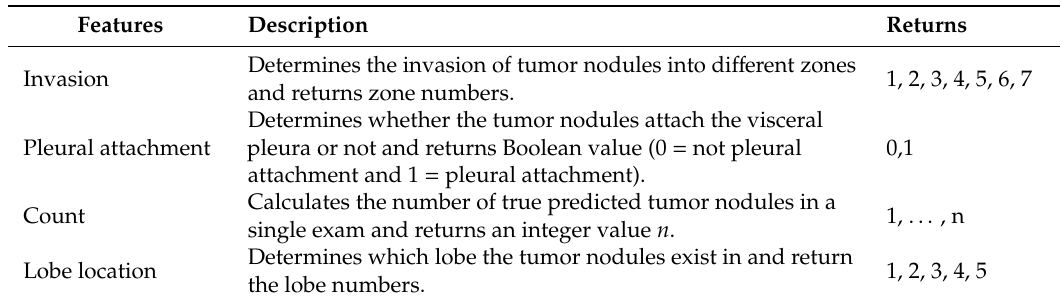
Table 3. Locational